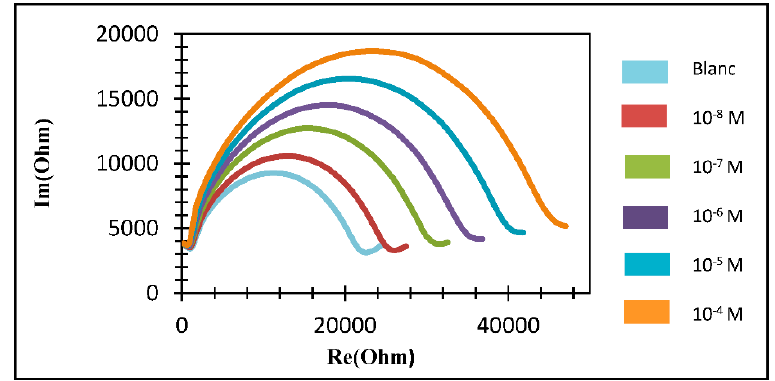
Figure 2. Nyquist diagrams obtained by EIS for metamitron concentration range from 10 − 8 M and 10 − 8 M in a solution of K 3 [Fe(CN) 6 ]/K 4 [Fe(CN) 6 ] 5 mM in phosphate buffer solution. Analysis parameters: frequency range from 470 kHz to 500 Hz. sinus amplitude 80 mV. Applied potential 0.2